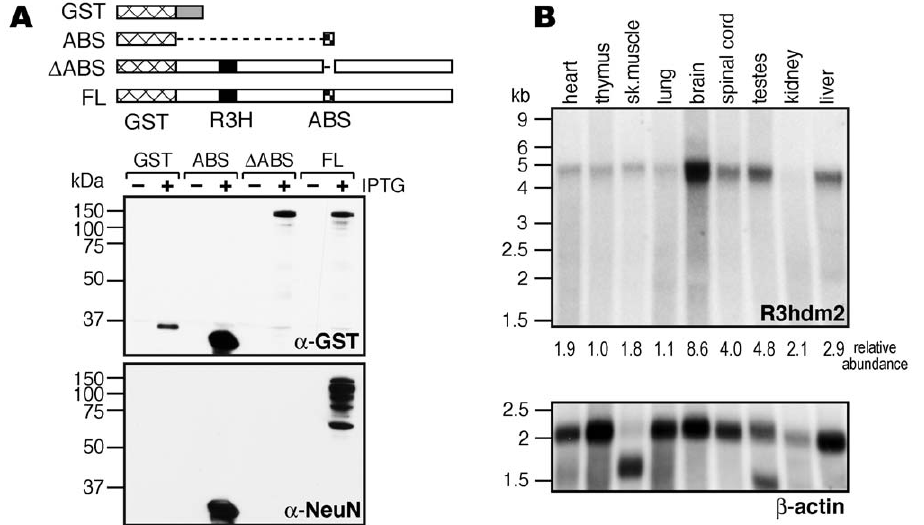
Figure 1. R3hdm2 reacts with anti-NeuN antibody. A. The depicted GST-fusion proteins were expressed in bacteria and cell lysates analyzed by western. The upper western panel (anti-GST) confirms that proteins of the expected sizes were expressed after IPTG induction. ABS=antibody binding site; FL=full-length R3hdm2; the R3H domain is also shown. The membrane was then stripped and reprobed with anti-NeuN antibody (lower panel), which indicates that the defined ABS region is both necessary and sufficient for anti-NeuN recognition of R3Hdm2. B. Northern of poly(A) + RNA isolated from adult mouse tissues and probed for R3hdm2. The level of R3hdm2 expression was normalised to b -actin (lower panel) for each tissue and calculated relative to the expression level in thymus.